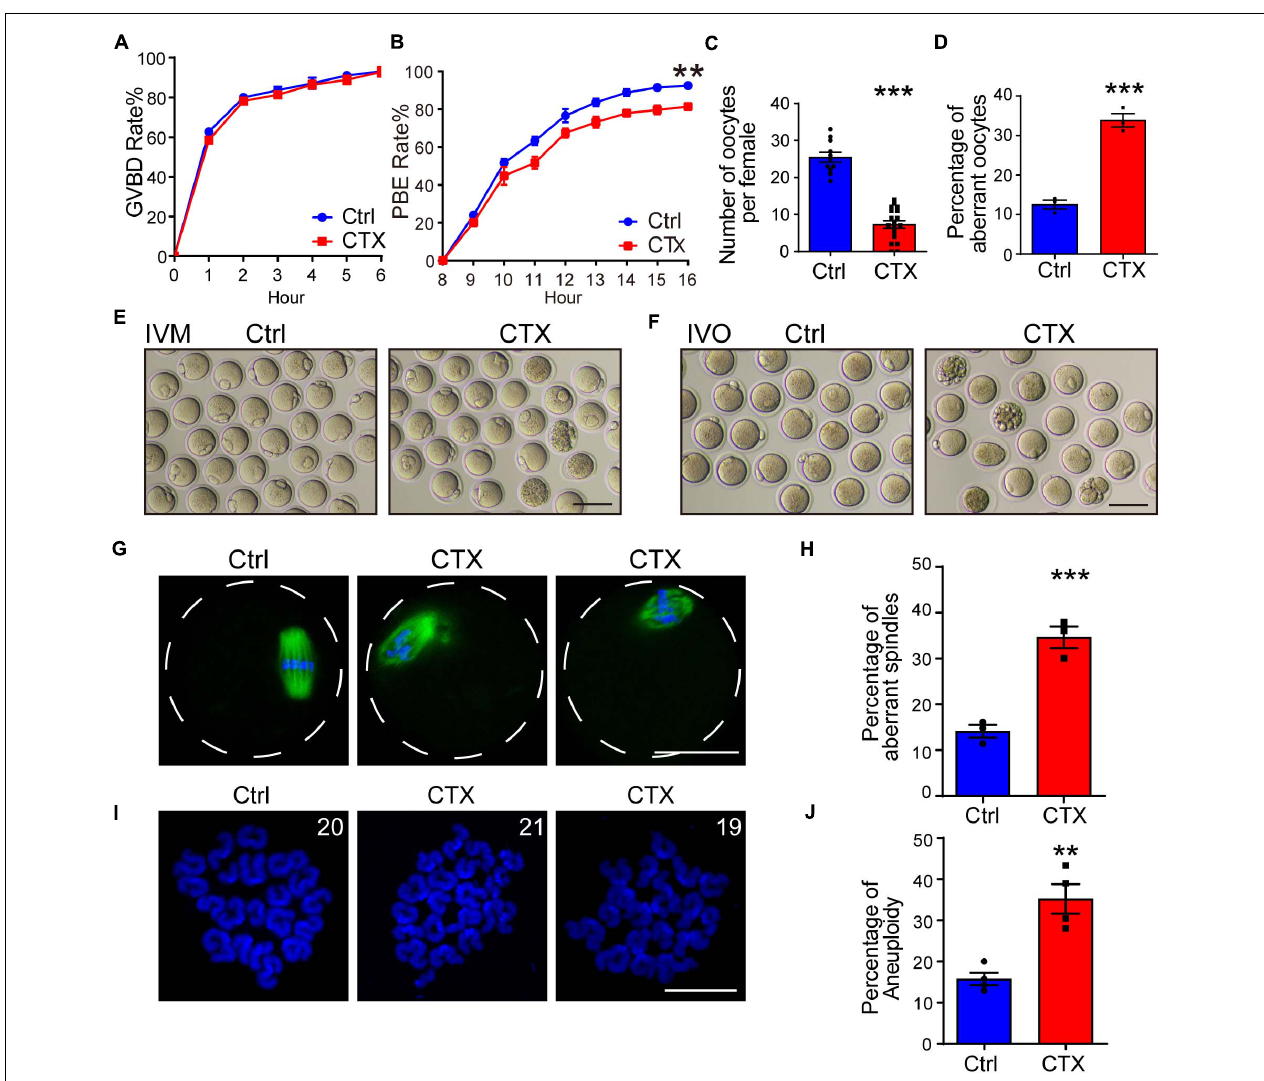
FIGURE 2 | Effects of CTX on the maturation, spindle morphology and aneuploidy of oocytes. (A,B) Rate of GVBD and PB1 extrusion of in vitro maturation oocytes from the two groups. (C) Analysis of superovulated oocyte numbers with or without CTX treatment after hCG injection. (D) Percentage analysis of aberrant morphology oocytes from two groups of mice. (E) Representative images of maturation of oocytes in (B) . Scale bar = 100 µ m (F) Representative images of aberrant oocytes in (D) . Scale bar = 100 µ m. (G) Typical images of correction and aberrant spindle assembly in oocytes. Scale bar = 50 µ m (H) Statistical analysis of incorrect assembly of spindles between the two groups of mice. (I) Representative chromosome spread images of euploid (20 pairs) and aneuploidy (19 or 21 pairs) oocytes. Scale bar = 10 µ m (J) Analysis of the differential proportion of aneuploidy between oocytes retrieved from the two groups. Data was presented as mean ± SEM. ** P < 0.01, *** P <